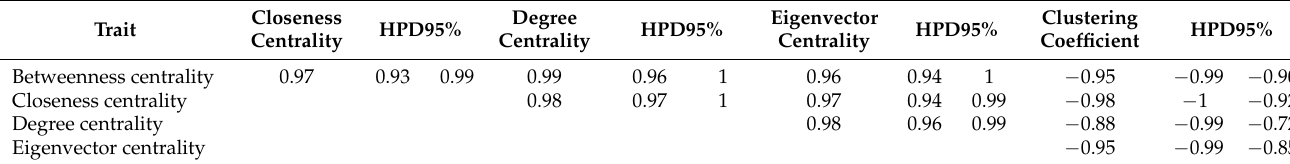
Table 4. Posterior means of the genetic correlations and the 95% highest posterior density intervals (HPD95%) for social network analysis traits for aggressive behaviour considered in this study.